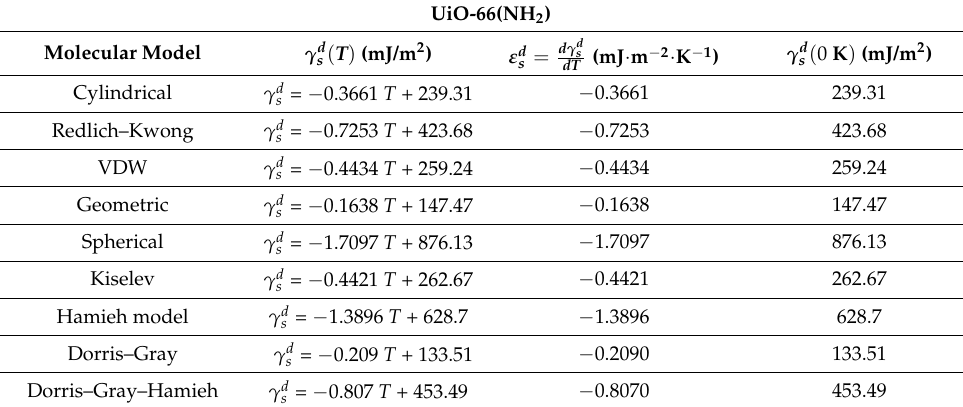
Table 5. Equations γ d s ( T ) of UiO-66(NH 2 ) surface, the dispersive surface entropy ε d s , and the extrapo- lated values γ d s ( 0 K ) by using the different molecular and thermal